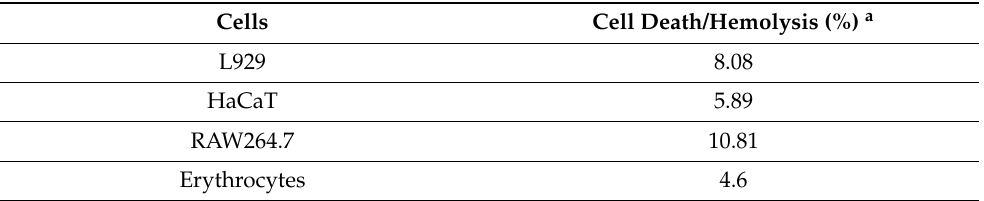
Table 3. Cytotoxicity and hemolysis of